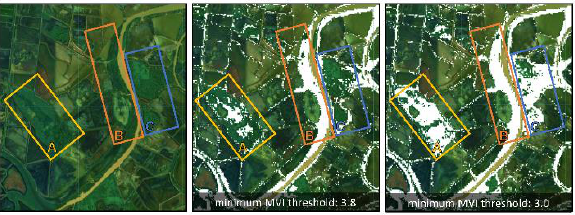
Figure 13 . Varying thresholds in a complex environment for clusters of mangroves in separate regions A (yellow), B (orange), and C (blue). The white pixels are those identified to be mangroves for the case MVI ≥ 3.8 (middle) and for the case MVI ≥ 3.0 (right).